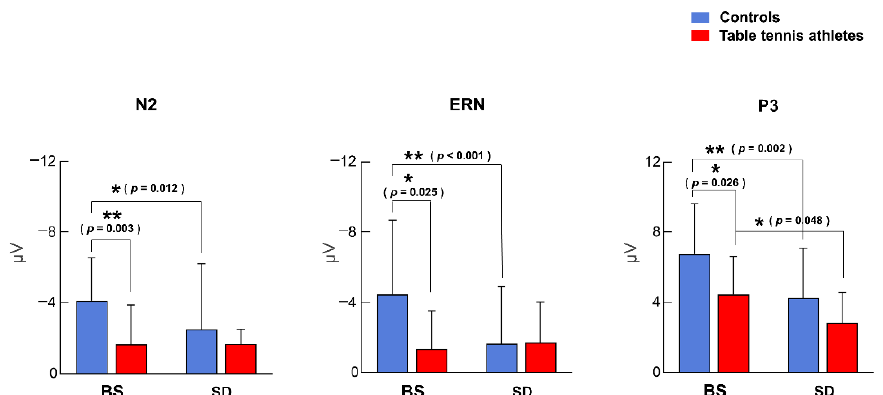
Figure 4. N2, ERN, and P3 component average amplitudes (mean ± SD). The blue bars represent the control group, and the red the table tennis athletes. * = p < 0.05, ** = p <